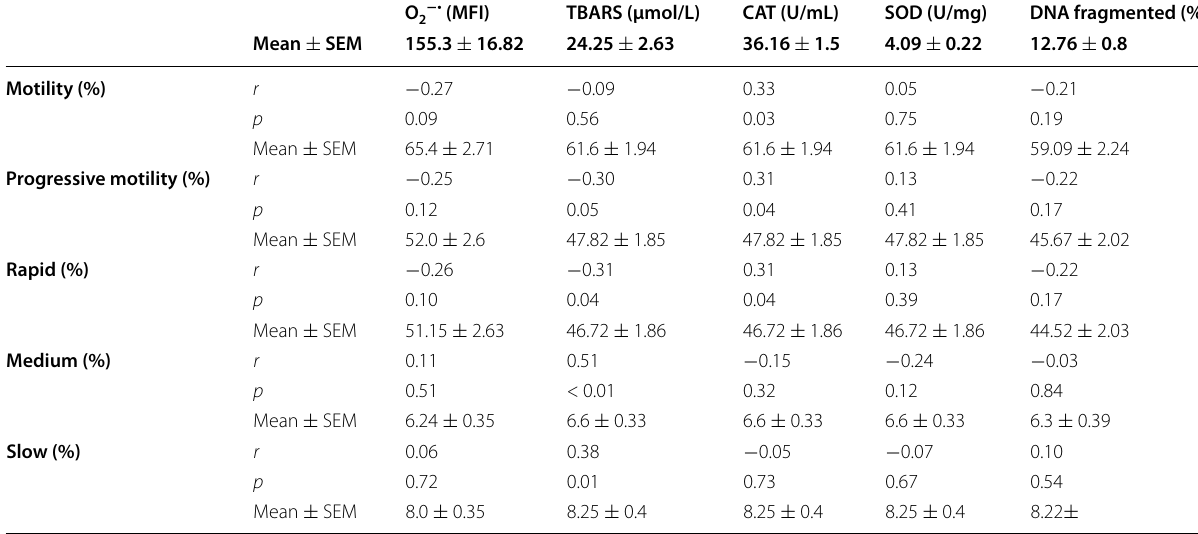
Table 2 Correlation analysis between sperm motility/velocity characteristics and advanced semen